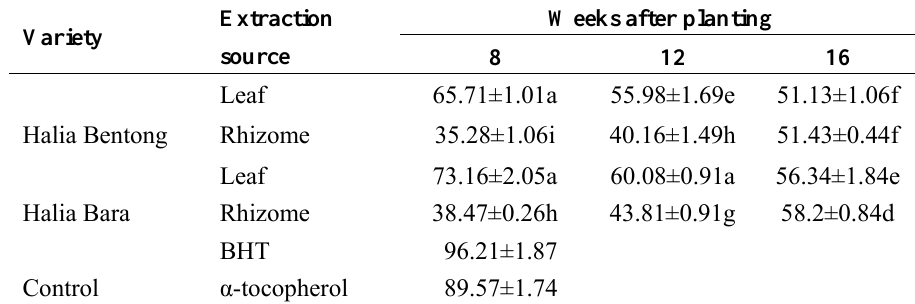
Table 3. DPPH scavenging activities of the methanolic extracts in different parts of two varieties of Zingiber officinale. BHT and α -tocopherol were used as positive controls.